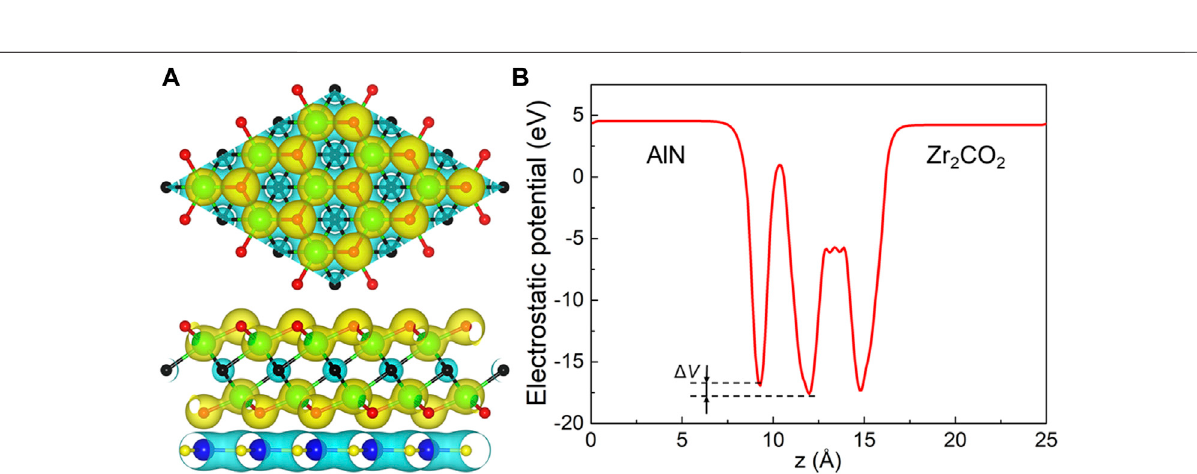
Frontiers in Chemistry |